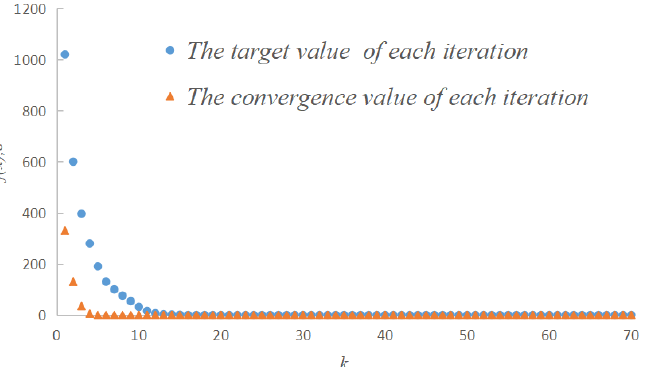
Figure 5. The changes in the target value and the convergence accuracy in the optimization iterations.